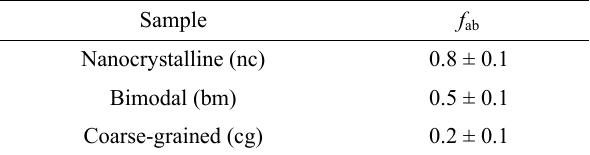
Fig. 6 Wear track profiles for all samples tested with a load of 5 N after 5 sliding cycles. Note that the values are in µm. Table 6 Cutting efficiency values ( f ab ) obtained from the wear track profiles for the tested